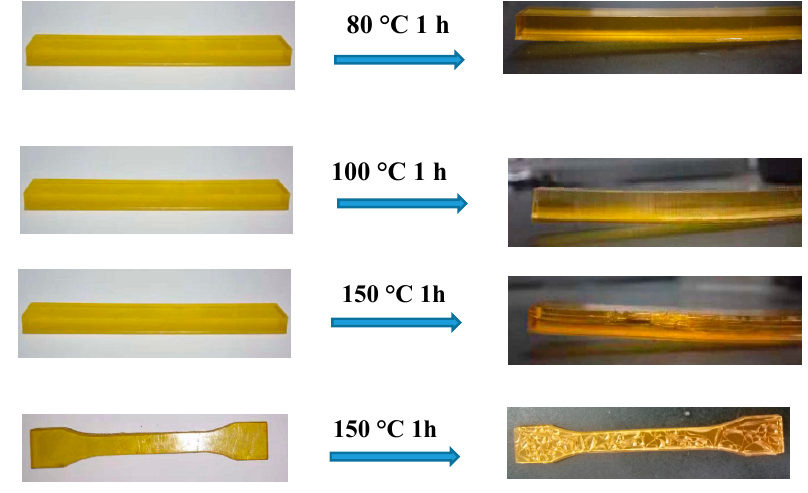
Figure 4. Morphological changes of the resin with different heat treatment conditions.